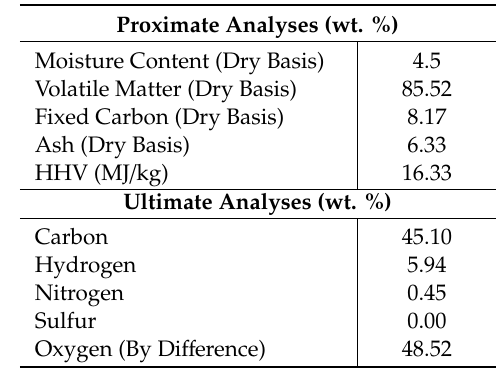
Table 1. Proximate and ultimate analysis for Napier